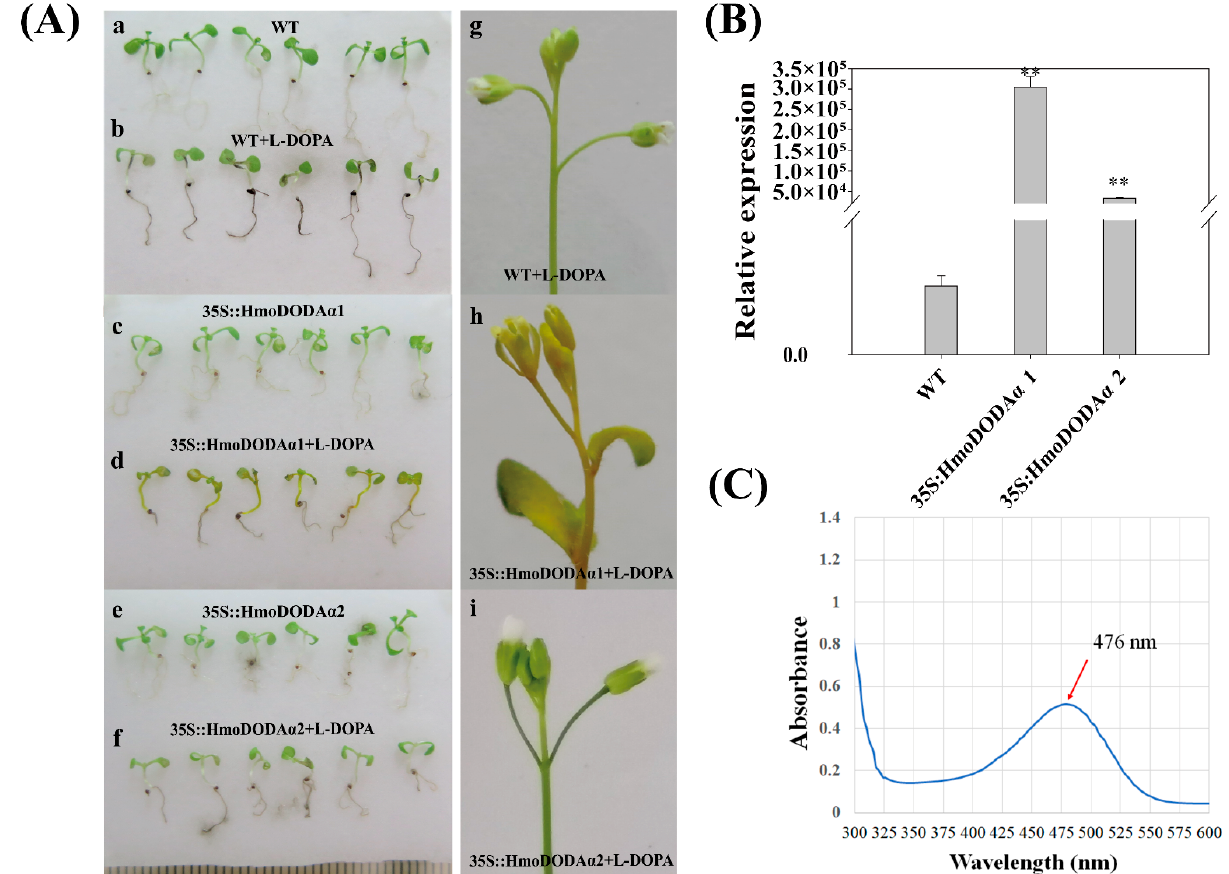
Figure 6. Genotypes of transgenic A. thaliana with HmoDODA α 1 and HmoDODA α 2 . ( A ) 35S::HmoDODA α 1 and 35S::HmoDODA α 2 seedlings were grown on moistened filter disks either without ( a , c , e ) or with ( b , d , f ) 10 mM L-DOPA. ( g – i ) The flowers of wild type and transformed with 35S::HmoDODA α 1 and 35S::HmoDODA α 2 feeding with L-DOPA. ( B ) Expression levels of HmoDODAs in transgenic A. thaliana seedlings. **: p < 0.01. ( C ) Maximum absorption of the pigment.